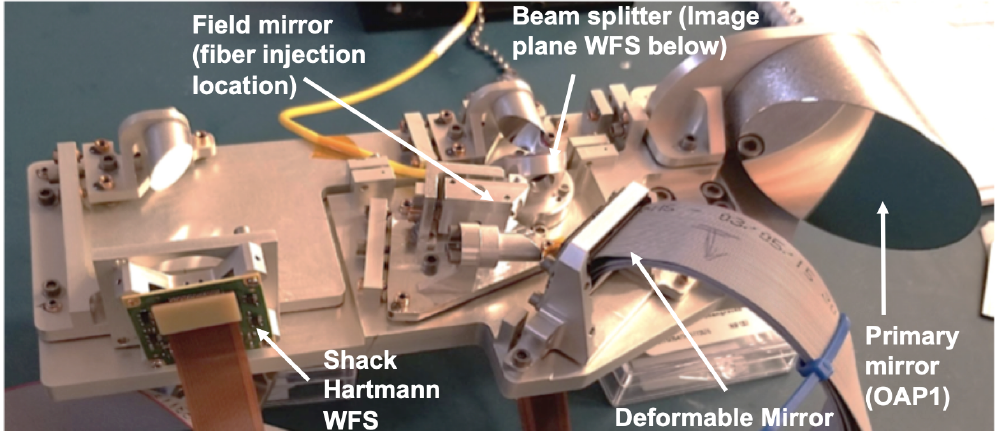
Figure 4. Engineering Model for the Deformable Mirror Demonstration Mission (DeMi) CubeSat Payload.